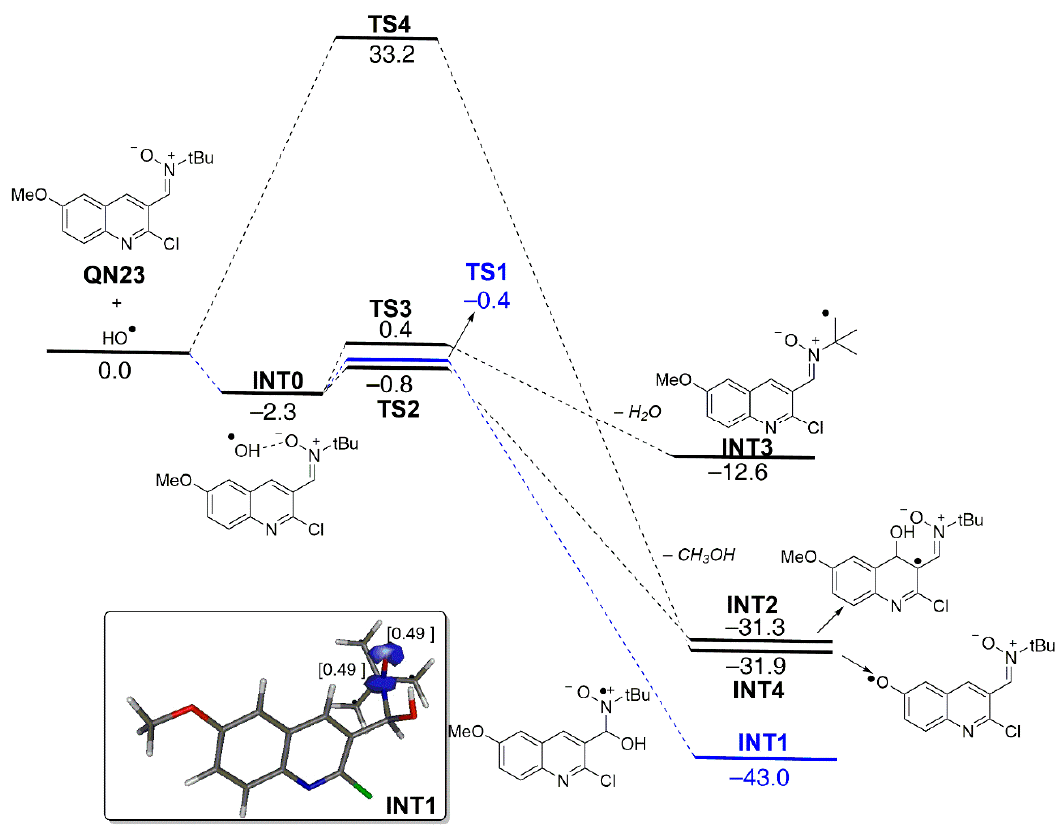
Figure 4. Computed reaction profiles for the reaction of QN23 and HO • . Relative free energy values ( Δ G, at 298 K) are given in kcal/mol. Inset: computed spin density for INT1 . All data have been computed at the B3LYP-D3/def2-SVP level.